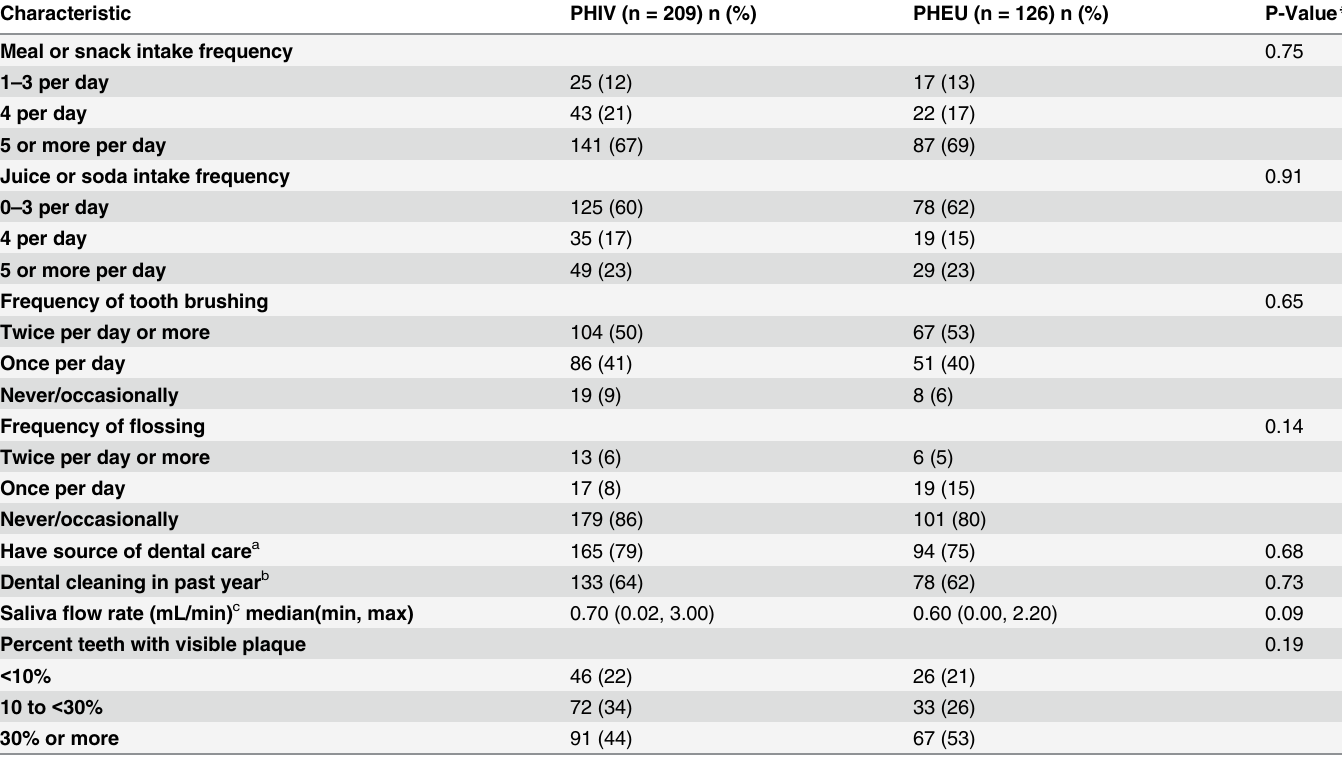
Table 2. Dietary habits, oral health history, and oral hygiene by HIV status among participants in the Pediatric HIV/AIDS Cohort Study (PHACS) Oral Health sub-study.